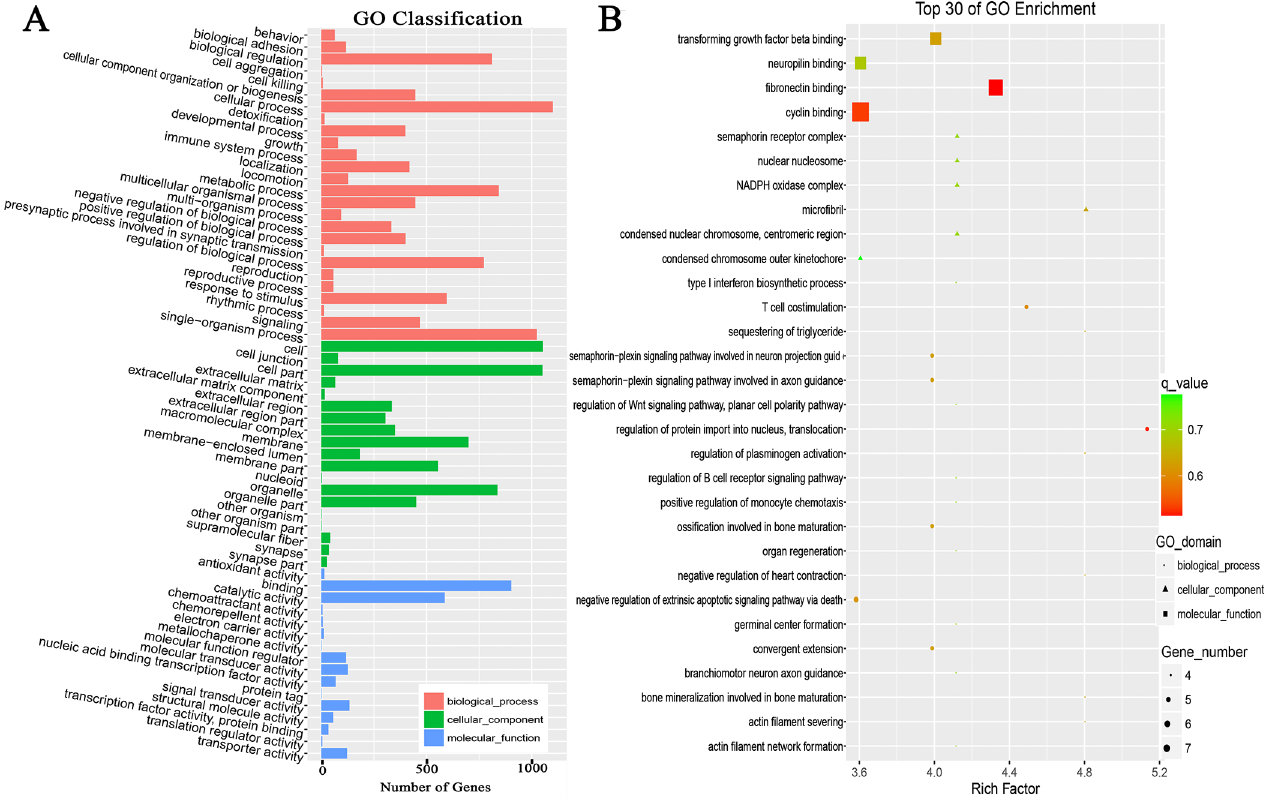
Fig 5. GO analysesof differentially expressedgenes in Gushi chickens and AA chickens. A shows the GO function classification (level 2), and B shows the 30 most significantly enrichedGO terms.